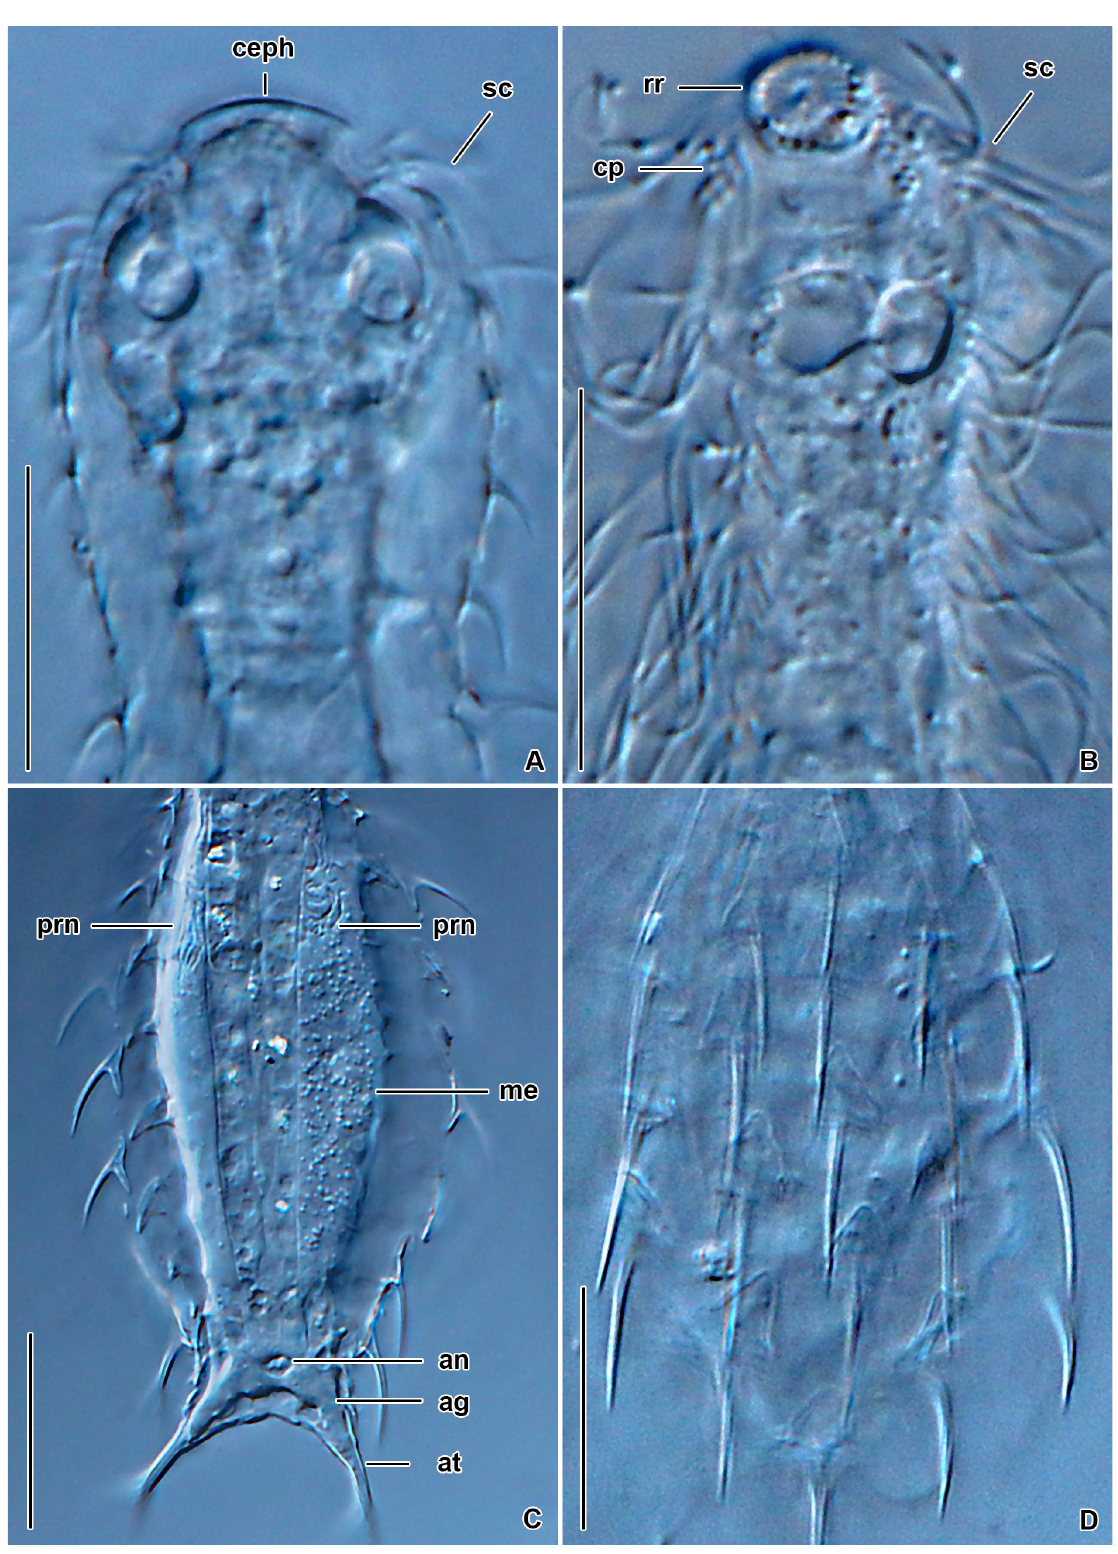
Fig. 35. Chaetonotus ( Hystricochaetonotus ) gulosus sp. nov., paratype (CU-FNS-28-10-19/PA), differential interference contrast. A–B . Details of the anterior body region. C . Optical section of the trunk and furca regions. D . Scale and spine pattern of the dorsal trunk region. Scale bars = 15